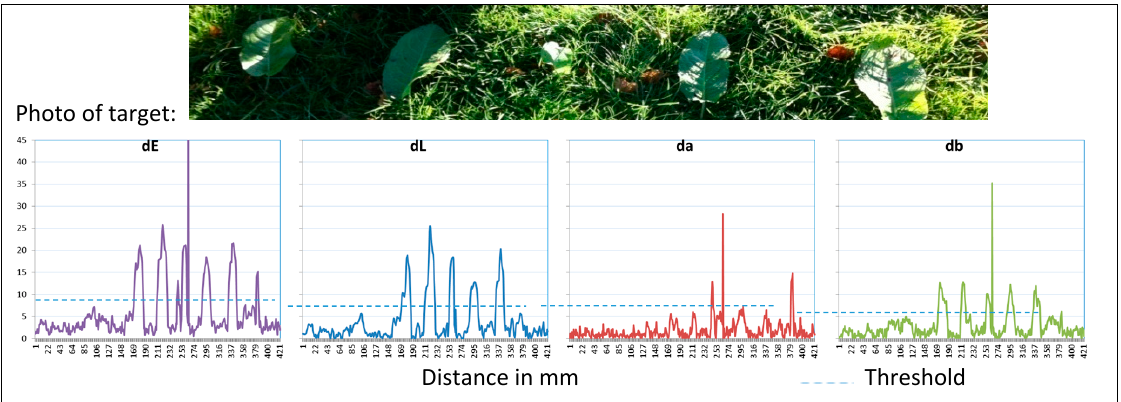
Figure 8. Reflection of grassland with dock, ∆E, ∆L, ∆a, ∆b and the defined threshold for detection.